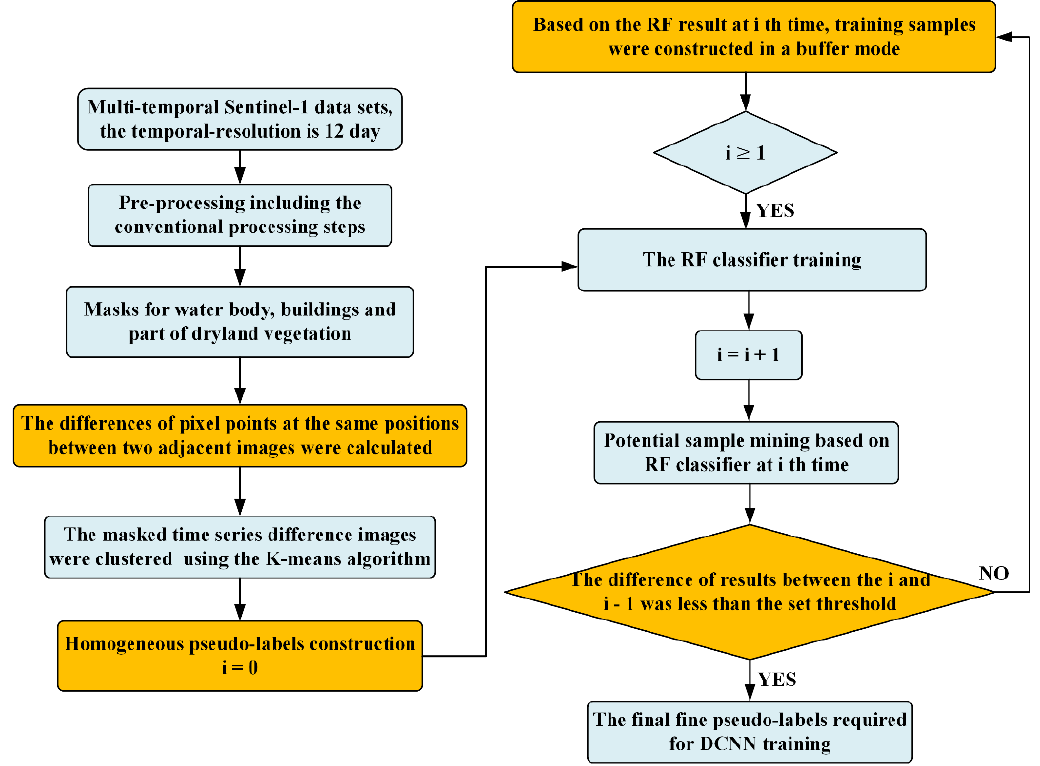
Figure 5. The pseudo-labels generation process based on K–RF.